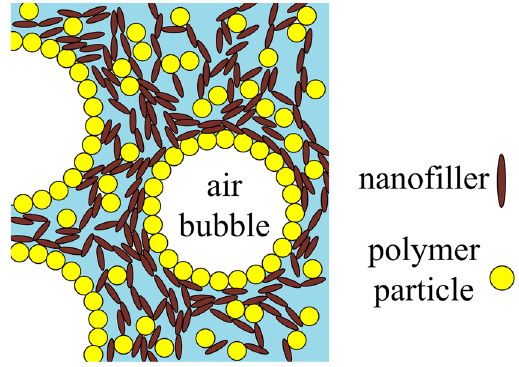
Figure 1. Schematic of the preferential adsorption of a binary system of polymeric particles and nanofillers to the liquid-air